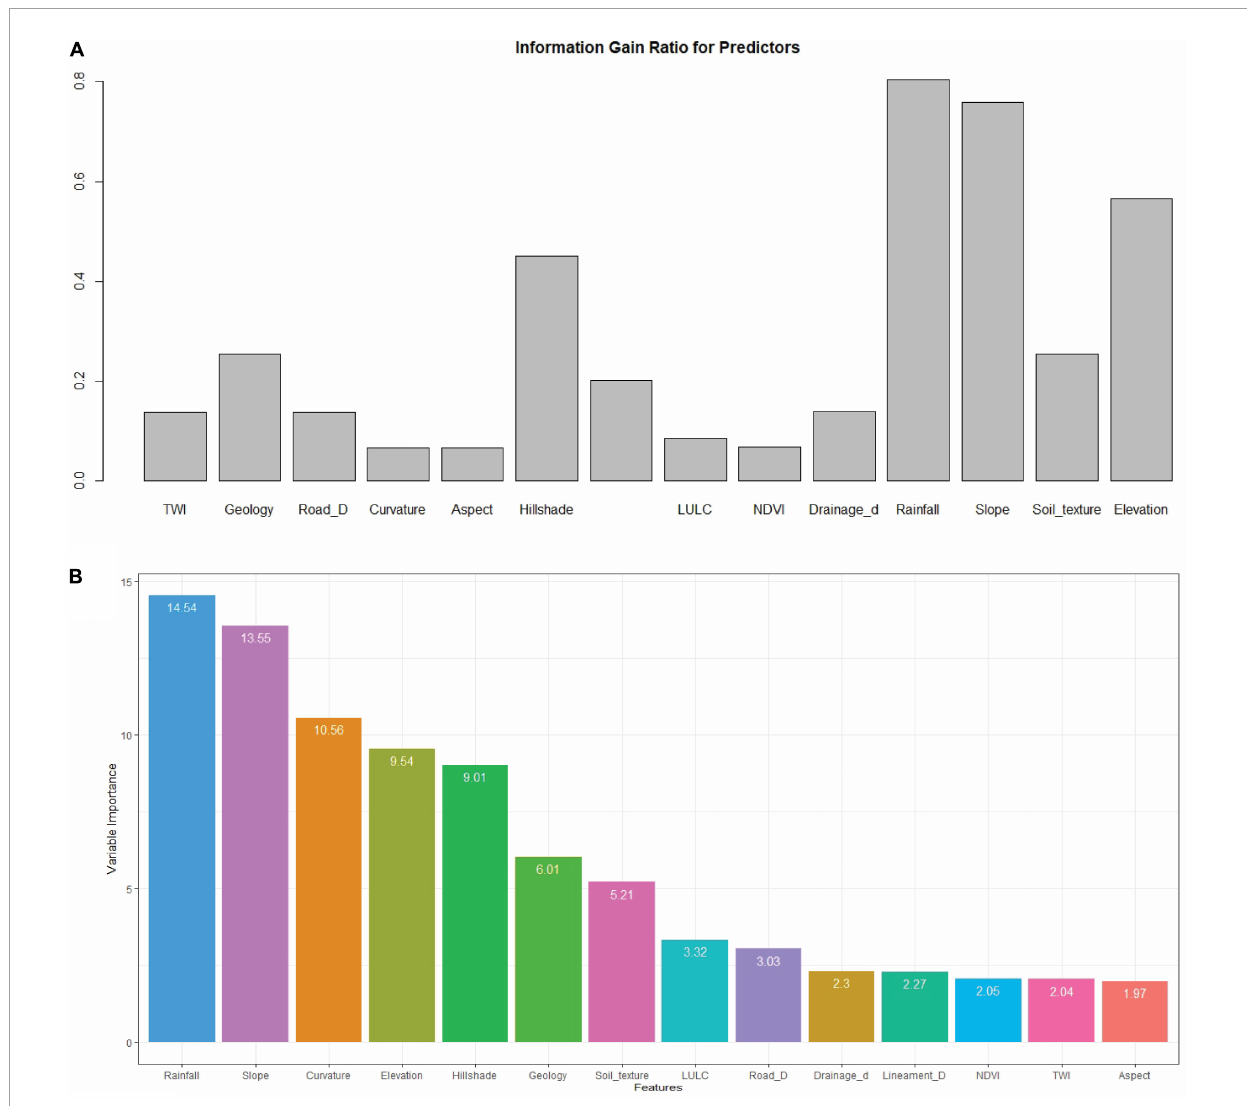
FIGURE4 Feature selection for evaluating the landslide conditioning factors using (A) information gain ratio, (B)